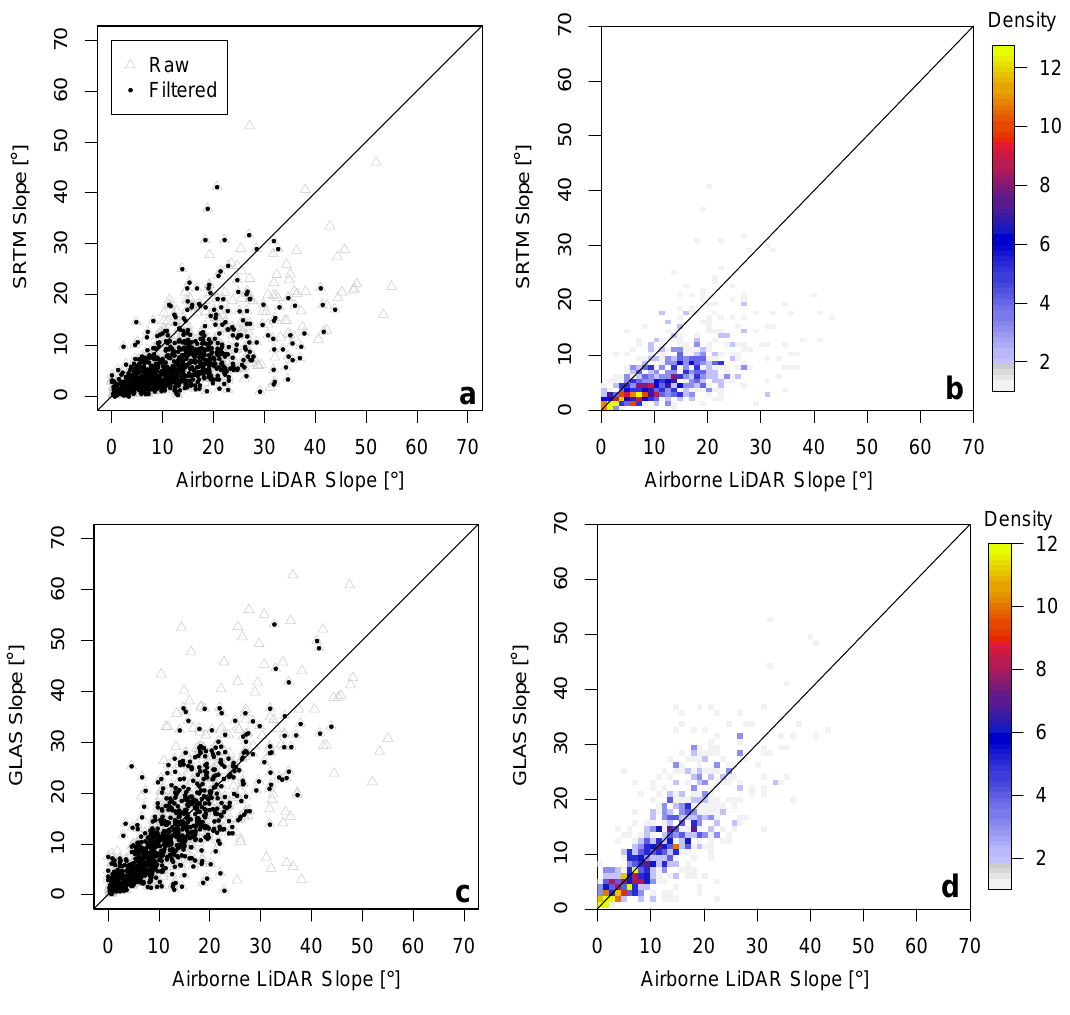
Figure 6. ( a ) Direct comparison and ( b ) density plot comparison of airborne LiDAR (ALS) slope and SRTM slope for seven sites. ( c ) Direct comparison and ( d ) density plot comparison of ALS and ISM slopes for all sites with available SRTM data (seven sites). Note: no SRTM data are available at Edsbyn and Norunda, as both sites are situated at latitudes beyond 60 ◦